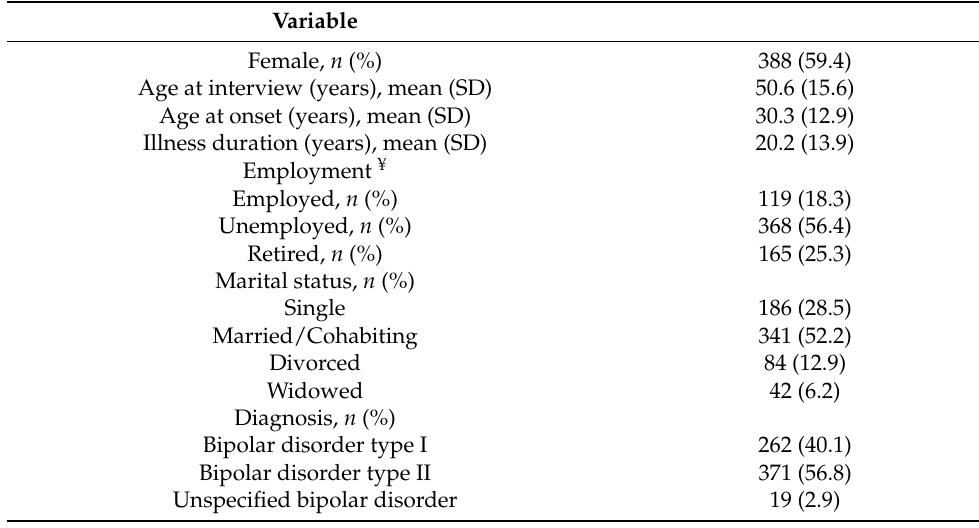
Table 1. Socio-demographic and clinical characteristics of bipolar disorder patients ( n =